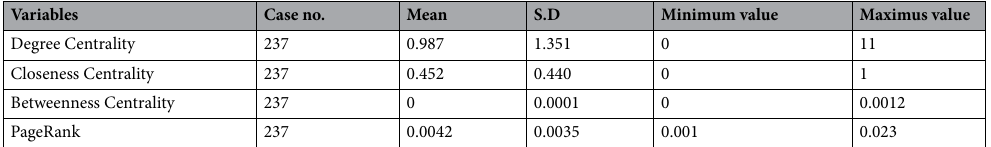
Table 3. Statistics of the contact network of COVID-19 cases in Shaanxi Province. The value of closeness centrality and betweenness centrality is in normalized